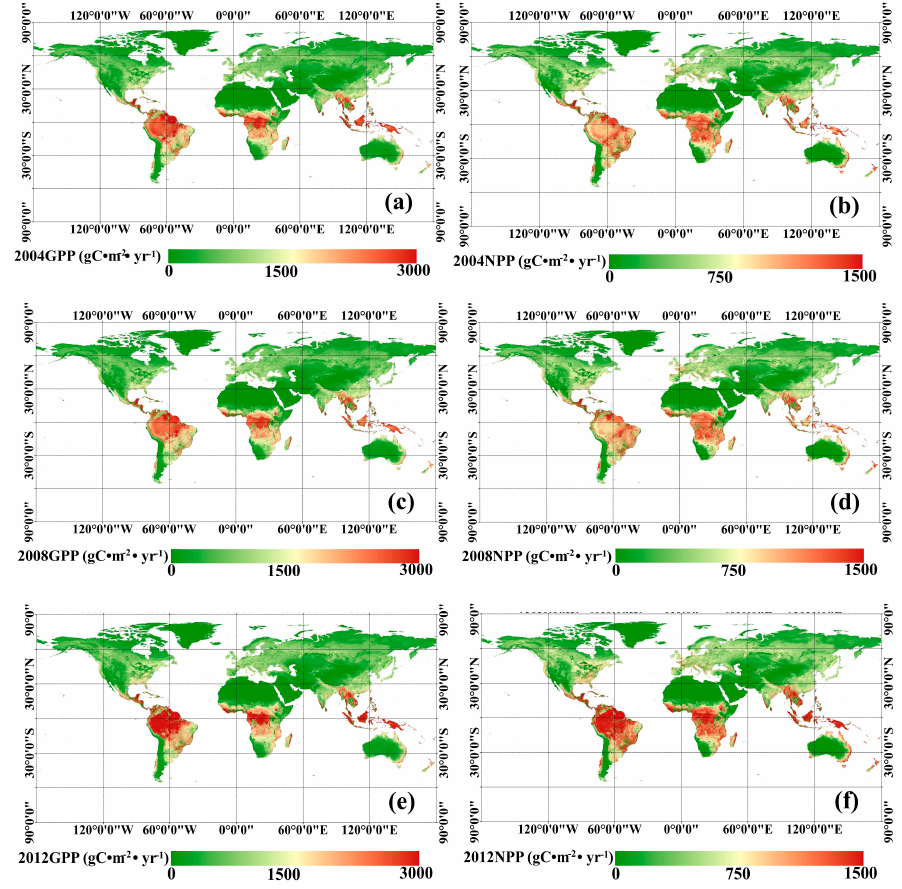
Figure 3. Global 1 km GPP and NPP in 2004, 2008 and 2012: ( a ) global GPP in 2004; ( b ) global NPP in 2004; ( c ) global GPP in 2008; ( d ) global NPP in 2008; ( e ) global GPP in 2012; ( f ) global NPP in 2012.